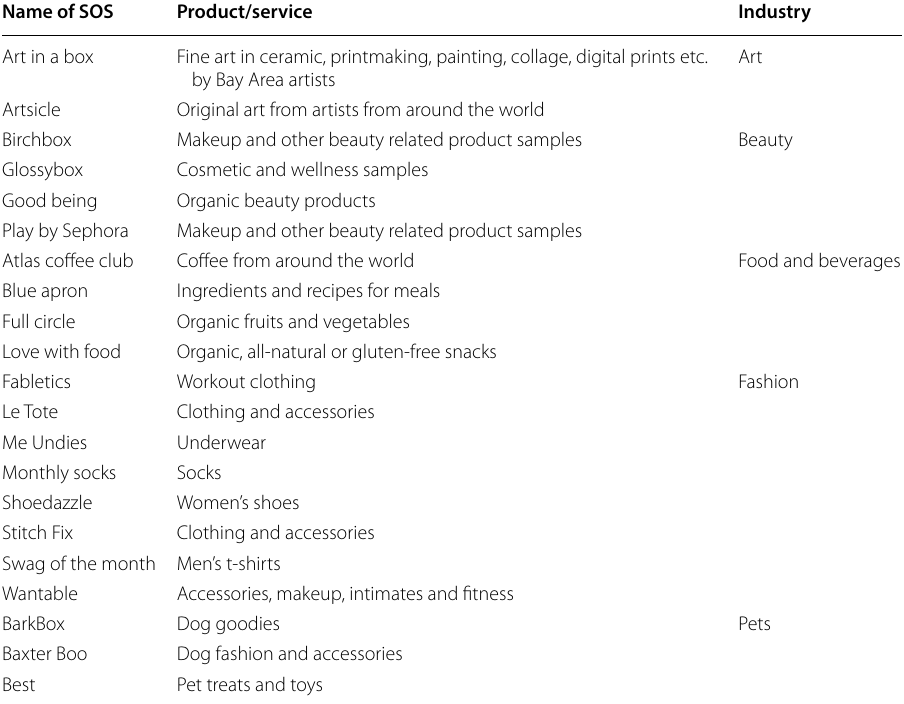
Table 1 Subscription-based online services (SOSs) in various product categories Name of